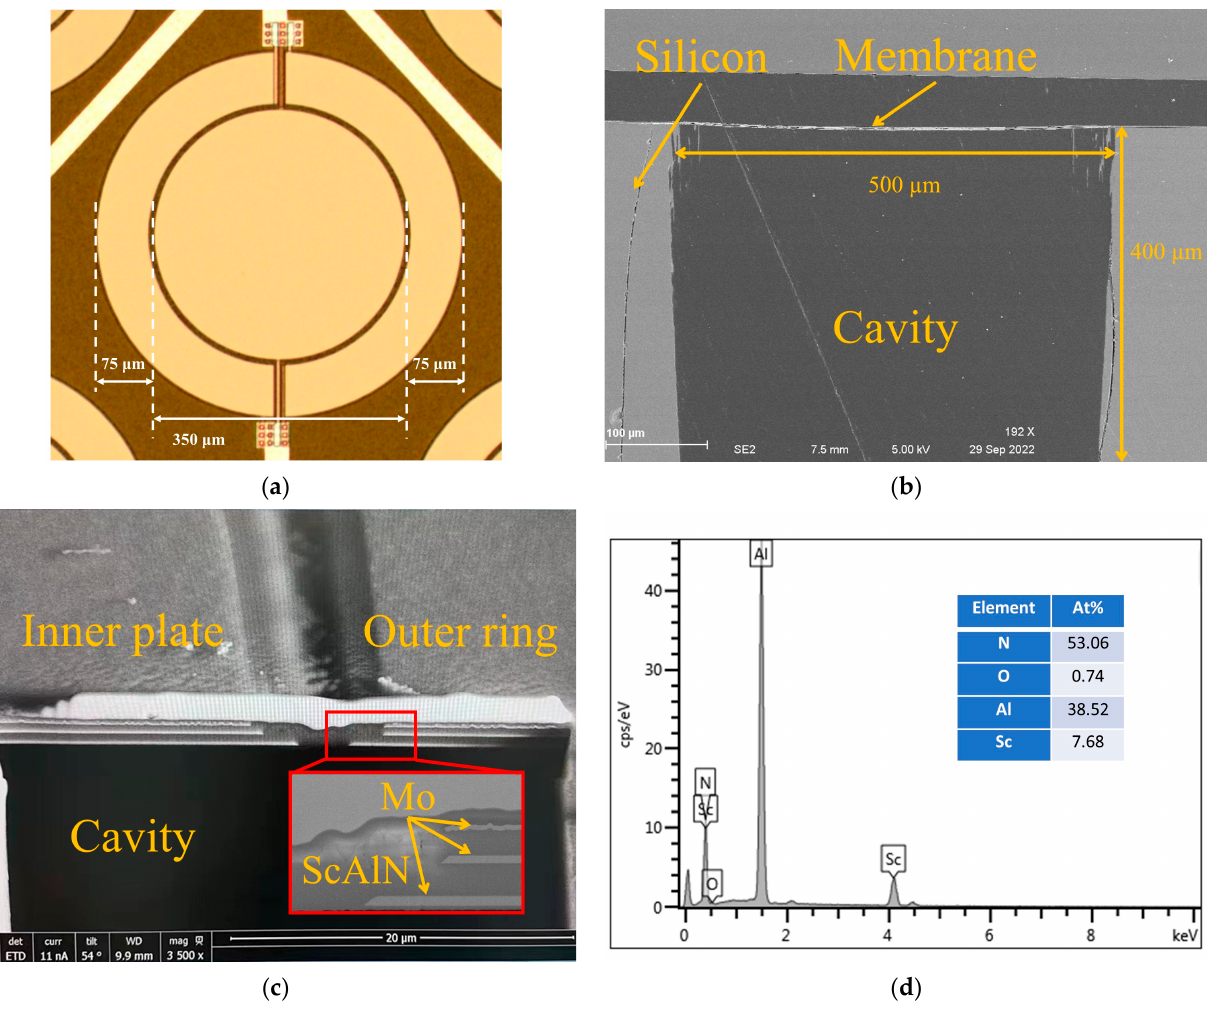
Figure 6. The fabrication results: ( a ) The optical microscope image of device top view; ( b ) The cross-section SEM image of bimorph dual-electrode ScAlN PMUT; ( c ) The bimorph films stack SEM image; ( d ) EDX results of Sc 0 . 2 Al 0 . 8 N films.